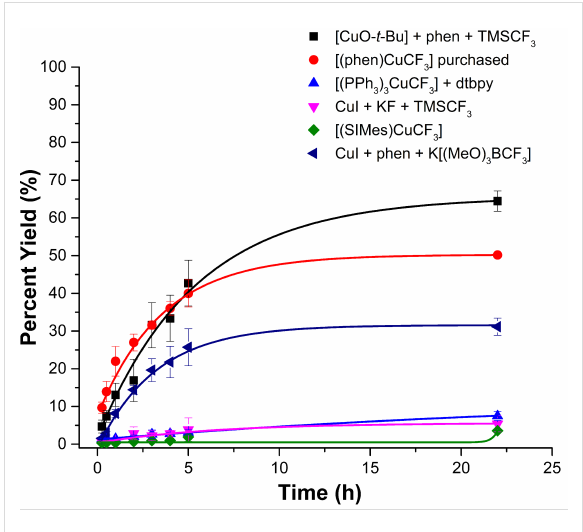
Figure 1: Yields of 4-(trifluoromethyl)-1,1’-biphenyl over time for the systems described in Scheme 1. These runs represent “standard” conditions described in Scheme 3 and the Experimental section. Yields were monitored by gas chromatography relative to a calibrated internal standard.